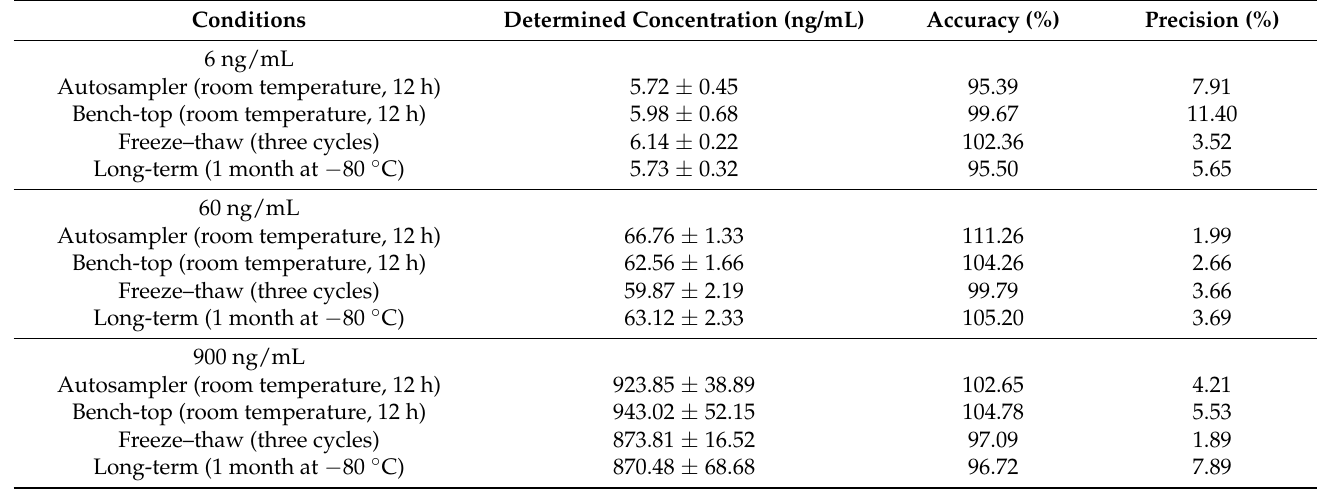
Table 3. Stability data for oxypeucedanin in rat plasma under different conditions ( n =